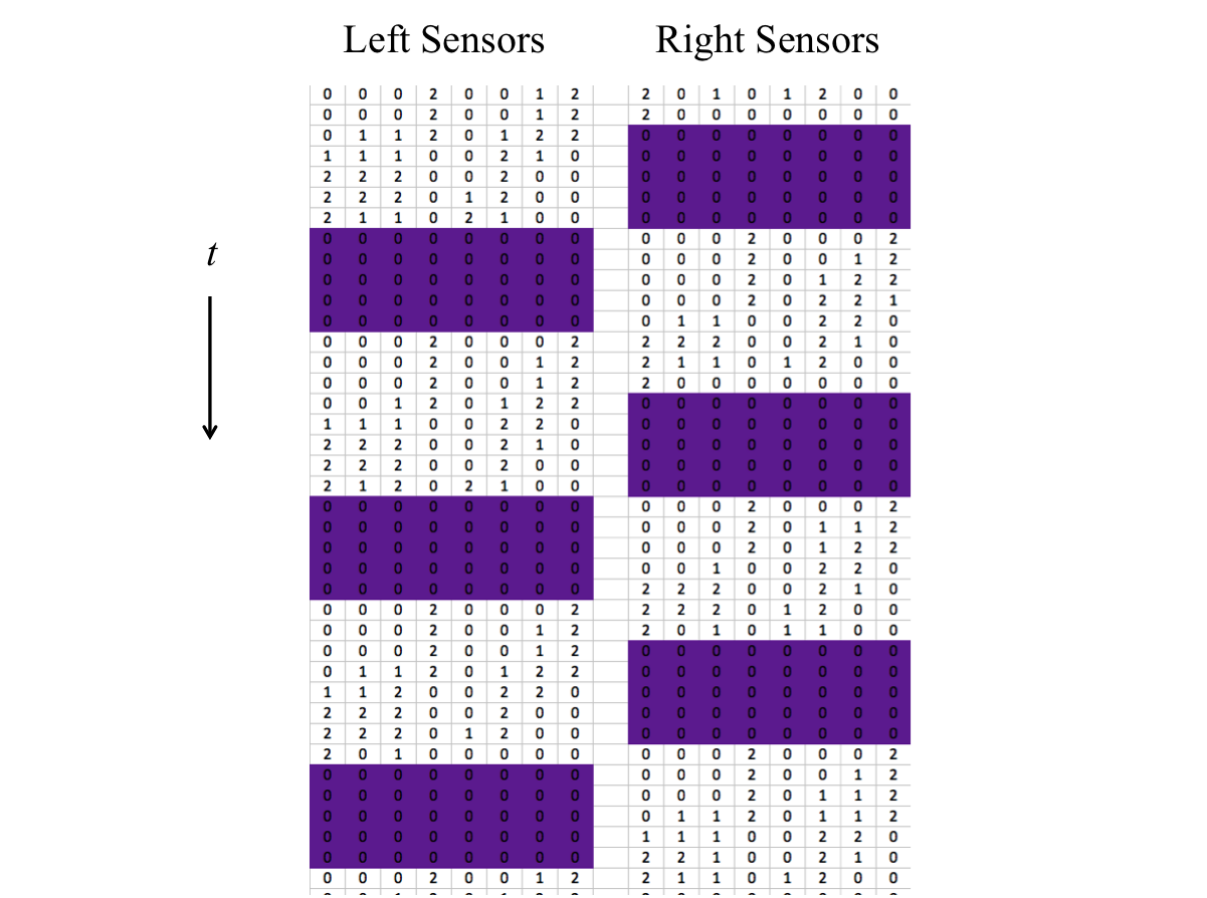
Figure 2. A sample of 4 seconds of raw data from the pressure sensors. The vertical position of each number of the array indicates the time, ordered from top to bottom at an increment of 0.1 seconds. Each column denotes a sensor, with left foot and right foot separated. The colored portions indicate when our algorithm decided the foot was off the